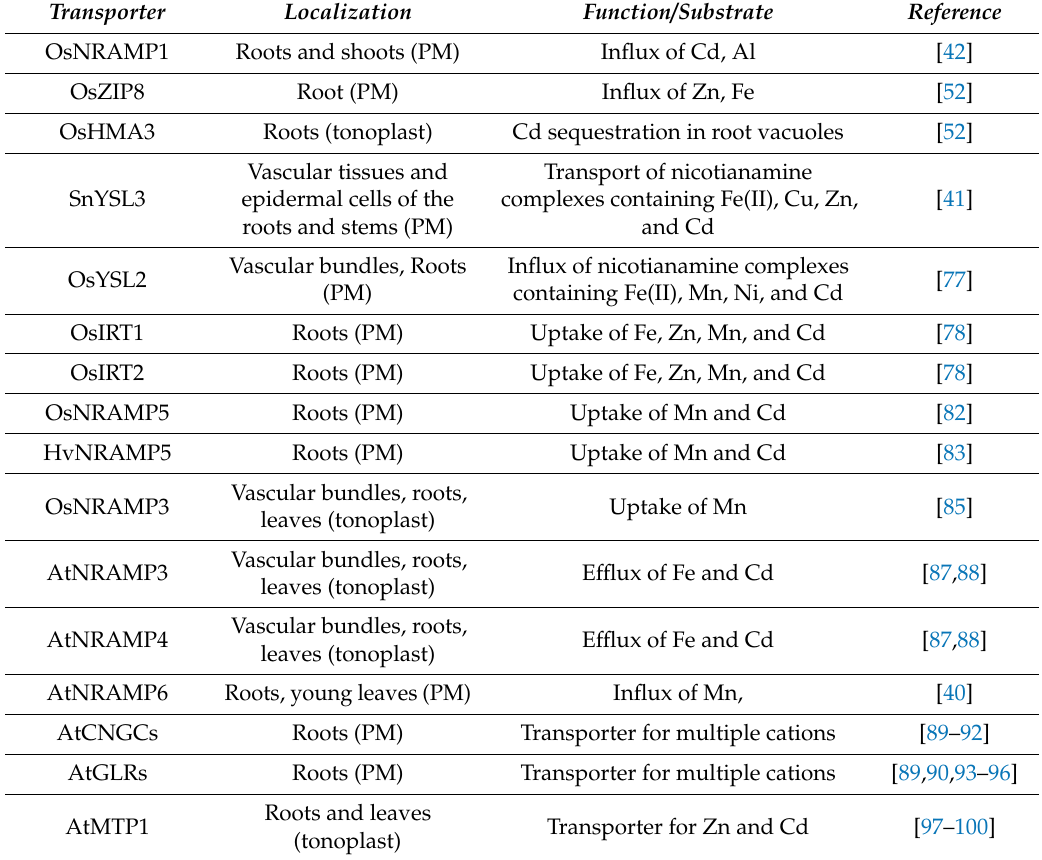
Table 2. Transporters mediating cadmium uptake and translocation in